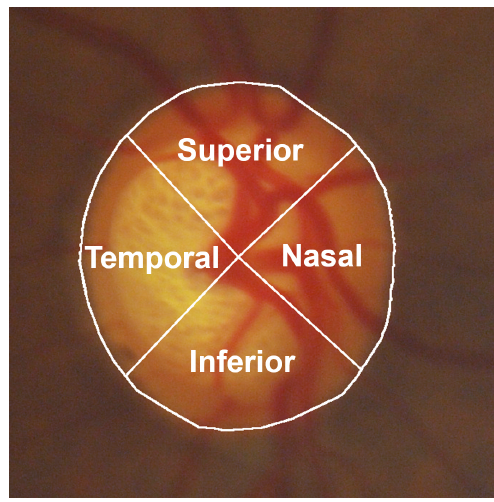
Figure 22. The four parts of OD. Table 2. The evaluation criteria of FSE.